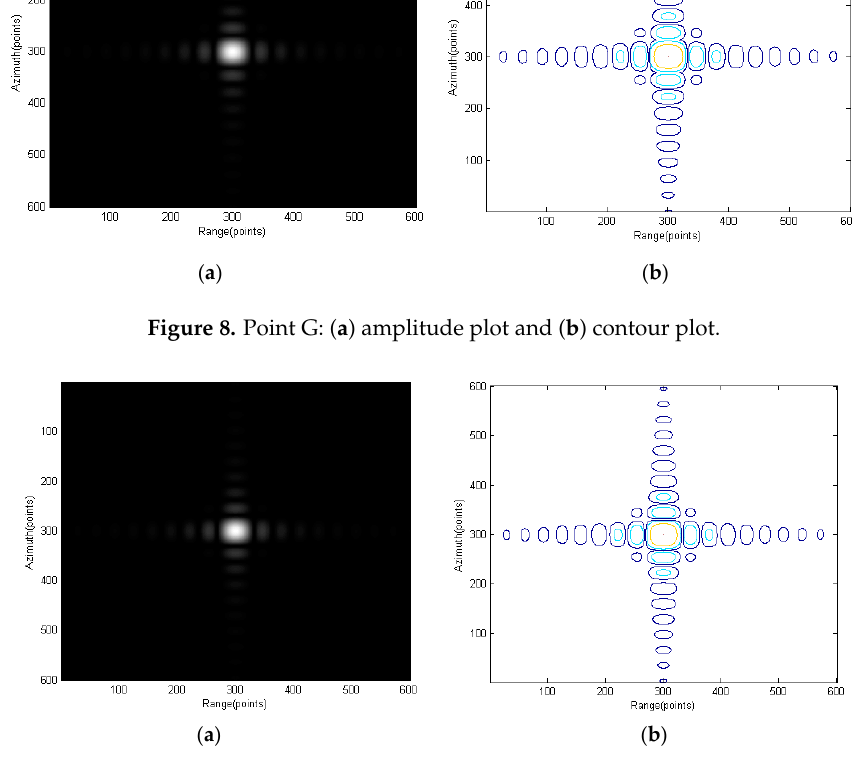
Figure 9. Point C: ( a ) amplitude plot and ( b ) contour plot.